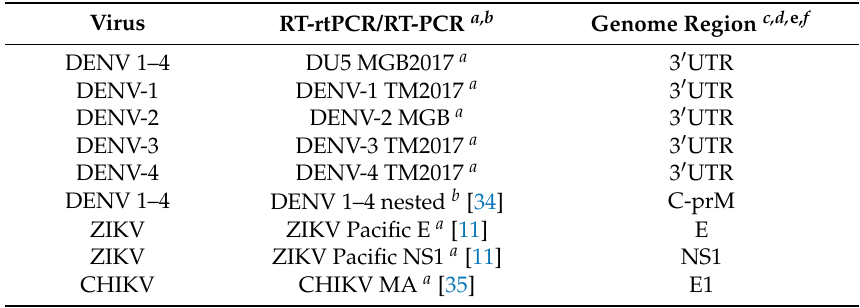
Table 1. RT-rtPCR assays for dengue virus (DENV), Zika virus (ZIKV), and chikungunya virus (CHIKV) currently used by the Public Health Virology Laboratory